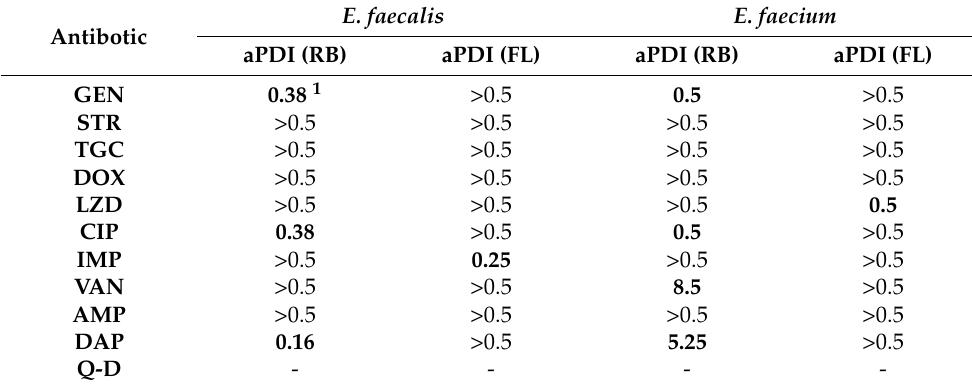
Table 3. Checkerboard FICI